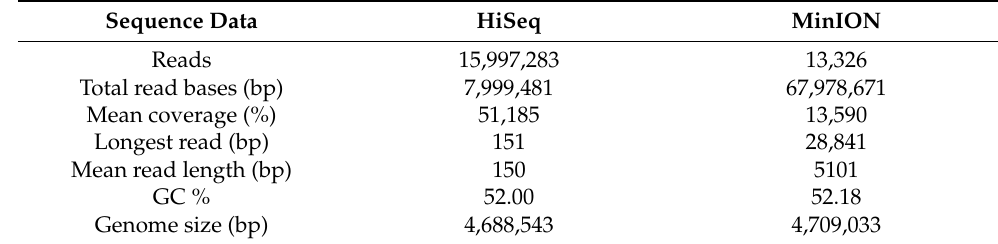
Table 1. Summary of the Illumina HiSeq and Oxford Nanopore MinION reads statistics after preprocessing step.